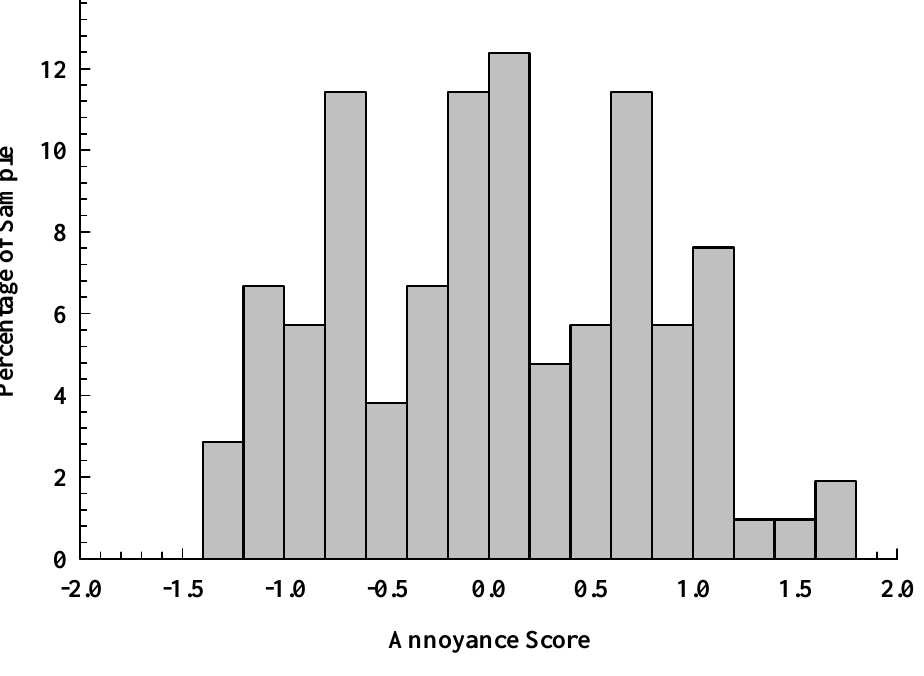
Figure 3. Histogram showing General Noise Annoyance scores. Scores were the mean of 12 standardized noise annoyance items. Of remark is the multimodal nature of the